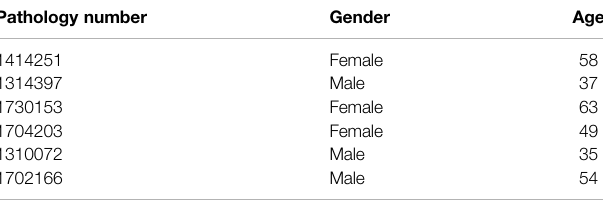
TABLE 4 | Basic information of